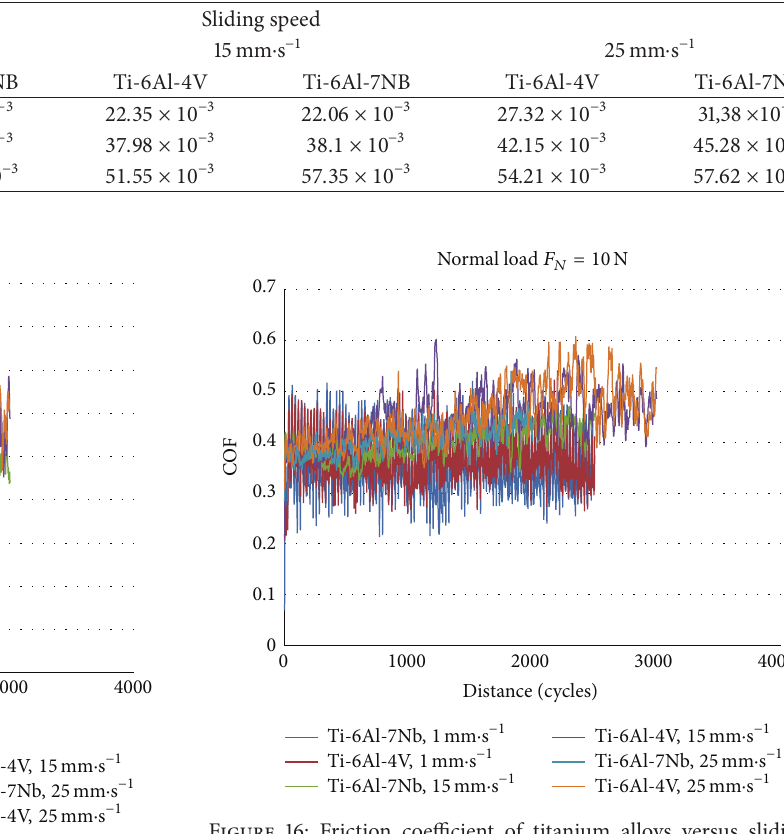
Table 6: Volumetric wear rate (mm 3 N − 1 ⋅ mm − 1 ) of Ti-6Al-7Nb and Ti-6Al-4V under different conditions.